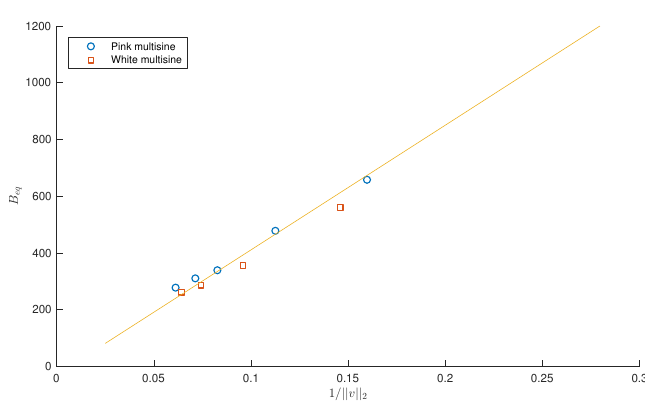
Figure 14. Equivalent linear damping is linearly proportional to the inverse of the 2-norm of the buoy velocity ( R 2 = 0.993).